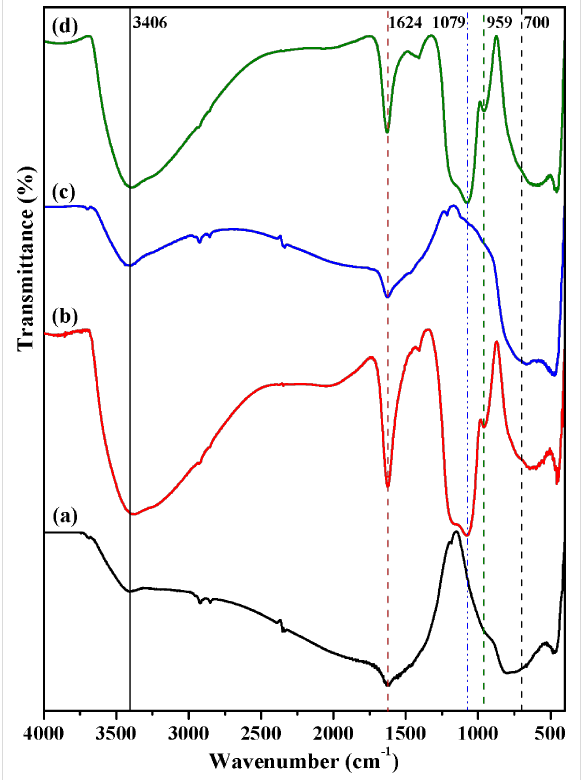
Figure 2: FTIR spectra of TiO 2 (a), TiO 2 /SiO 2 (b) TiO 2 /Fe 2 O 3 (c) and TiO 2 /SiO 2 /Fe 2 O 3